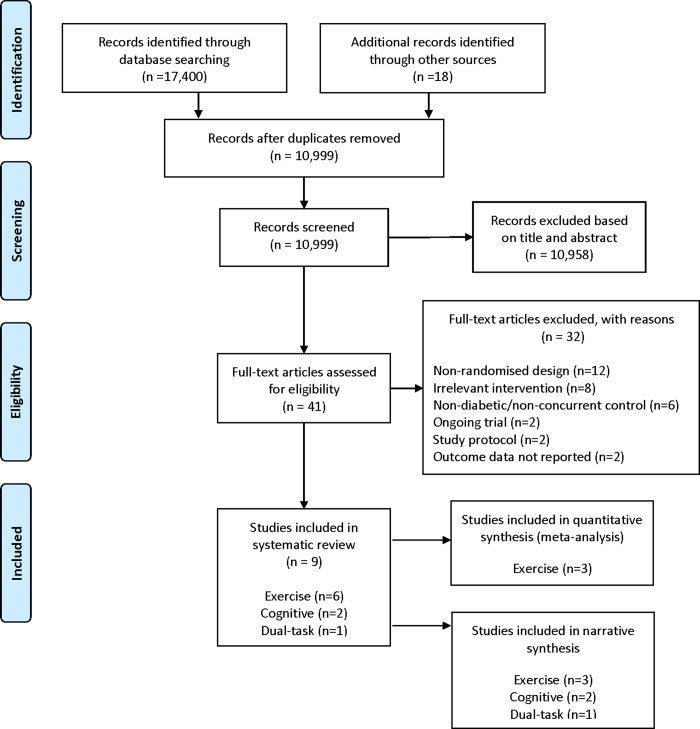
Study flow chart [53].